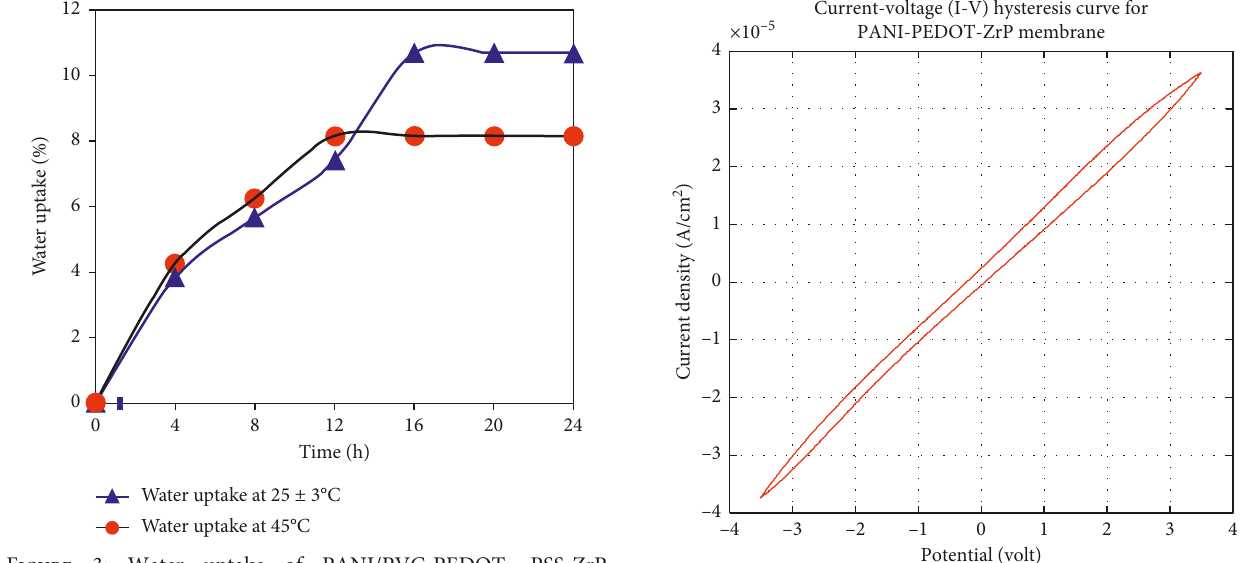
Figure 5: Cyclic voltammetry study of PANI/PVC-PEDOT: PSS- ZrP membrane.